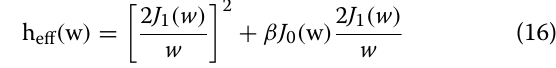
figure on next Fig. 2 a : Circular aperture with irregular spikes in a matrix of dimensions 2048 image or the intensity impulse response corresponding to the aperture is shown in ( a ). c : The Normalized PSF plot in the range from 990 up to 1058 pixels obtained from the image is shown in the ( b ). d : The PSF, for the 1st model in the range from 1040 up to 1100 pixels. The profile is plotted at constant x 1024 pixels. e : The PSF, for the 1st model in the range from 1040 up to 1100 pixels. The profile is plotted at constant y =